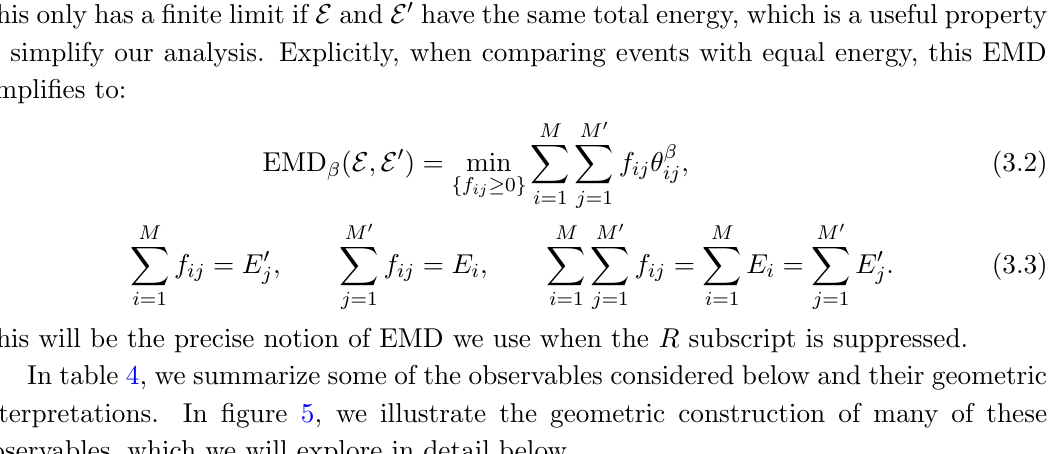
Table 4 . Observables as the EMD between the event de(cid:12)nition in eq. (3.2). Several of these observables are illustrated in (cid:12)gure 5. Here, we consider only the \recoil-free" versions of these